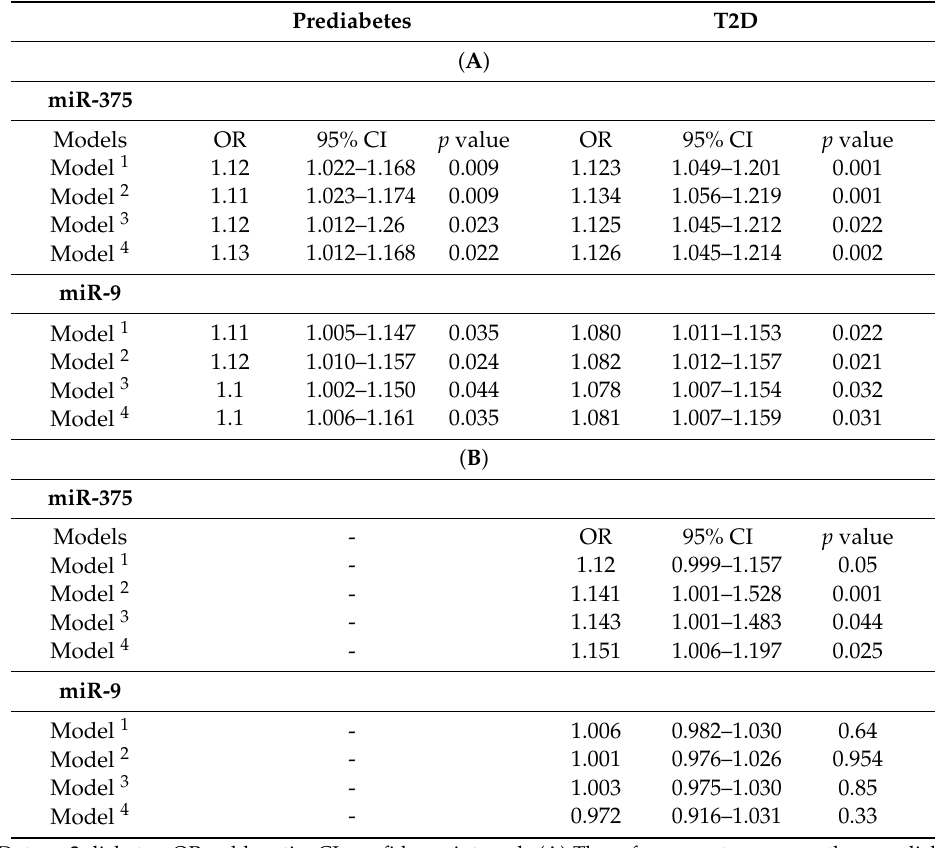
Table 3. ( A ) Multivariate regression analysis of miRNAs for the presence of prediabetes and T2D. ( B ) Multivariate regression analysis of miRNAs for the development of T2D. Prediabetes